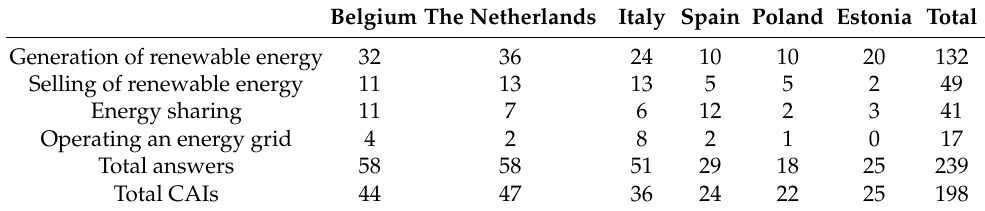
Table 8. Energy-Supply Chain Activities.